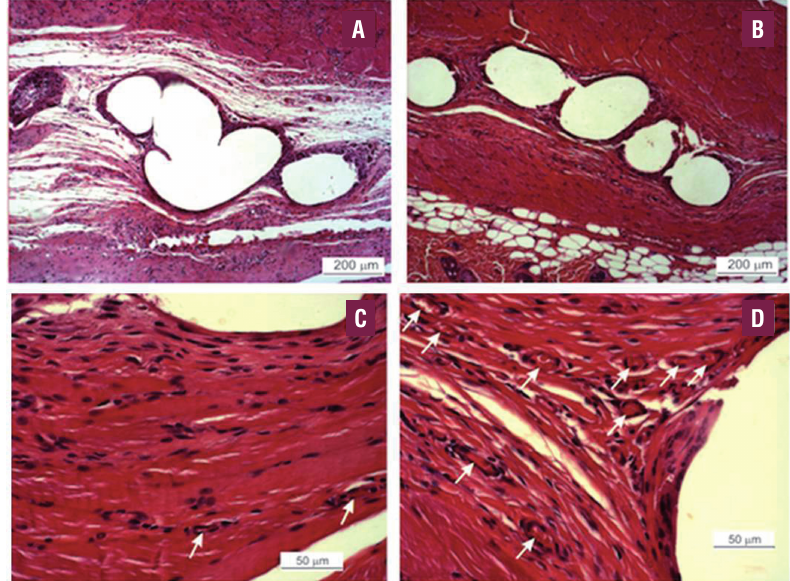
(Figure is a courtesy of author: Prudente el al., 2013).